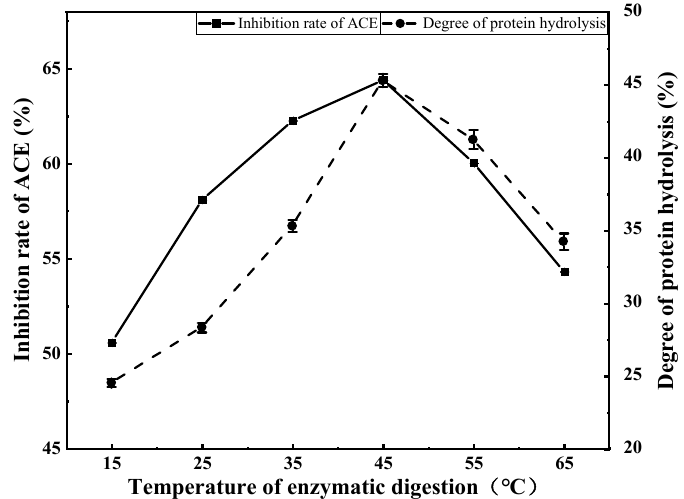
Figure 5. The effect of enzymatic hydrolysis temperature on the inhibition rate of ACE and the degree of protein hydrolysis.